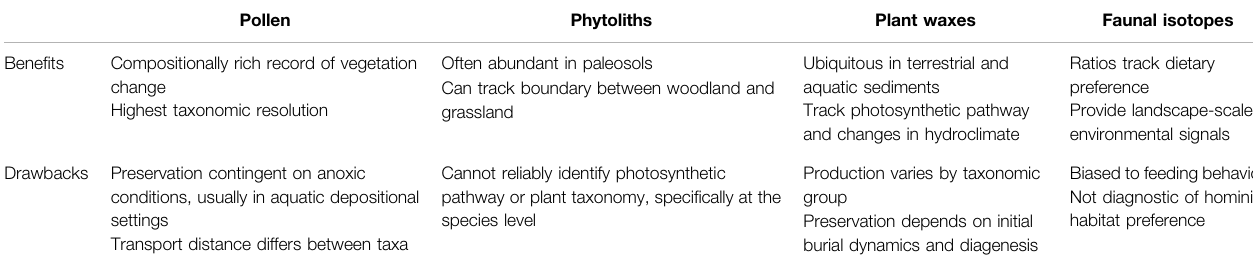
TABLE 2 | Main paleoecological proxies that can be used to study microhabitat variability.